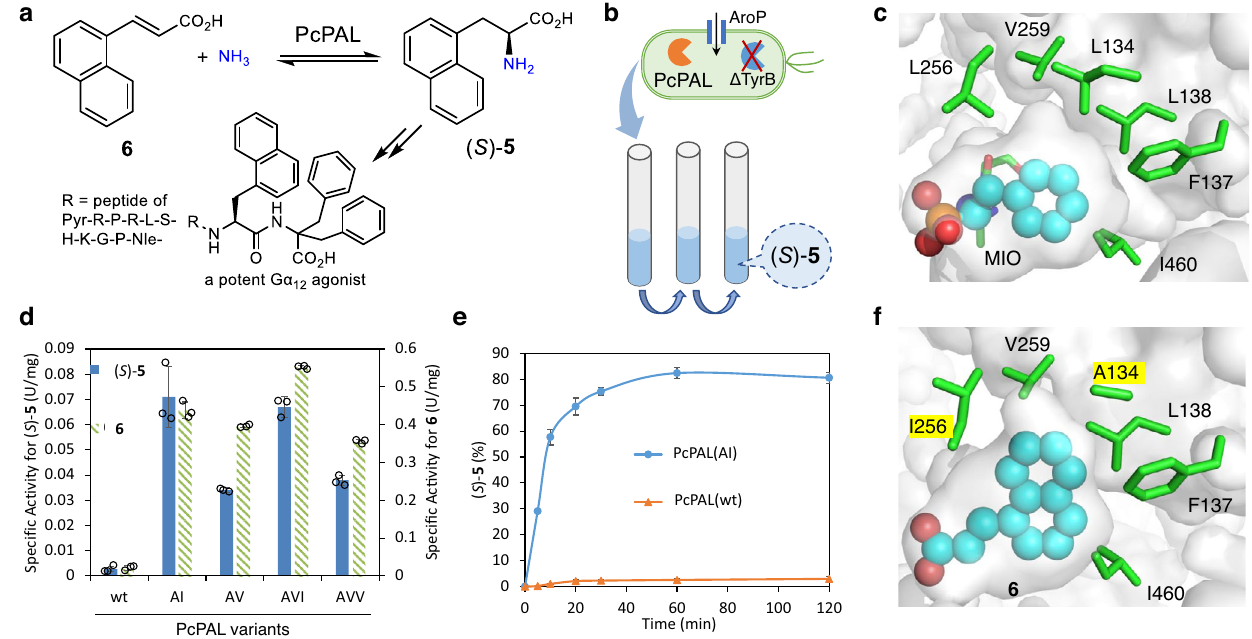
Fig.5|Growth-baseddirectedevolutionofPcPALfortheasymmetricsynthesis of ( S )-5. a Targeted reaction to convert 6 to ( S )- 5 . b The principle of the growth selection is based on E. coli Δ tyrB co-expressing PcPAL variants and a transporter (AroP) in the M9 liquid medium where the amino acid ( S )- 5 serves as the only nitrogen source. c Identi fi cation of six key residues by analyzing the active site of PcPAL(wt) (PDB: 6HQF) with ( R )-(1-amino-2-phenylethyl)phosphonic acid (inhi- bitor, represented as cyan spheres). d Speci fi c activities of puri fi ed PcPAL variants forconverting ( S )- 5 and 6 . e Time course of the asymmetric synthesisof ( S )- 5 from